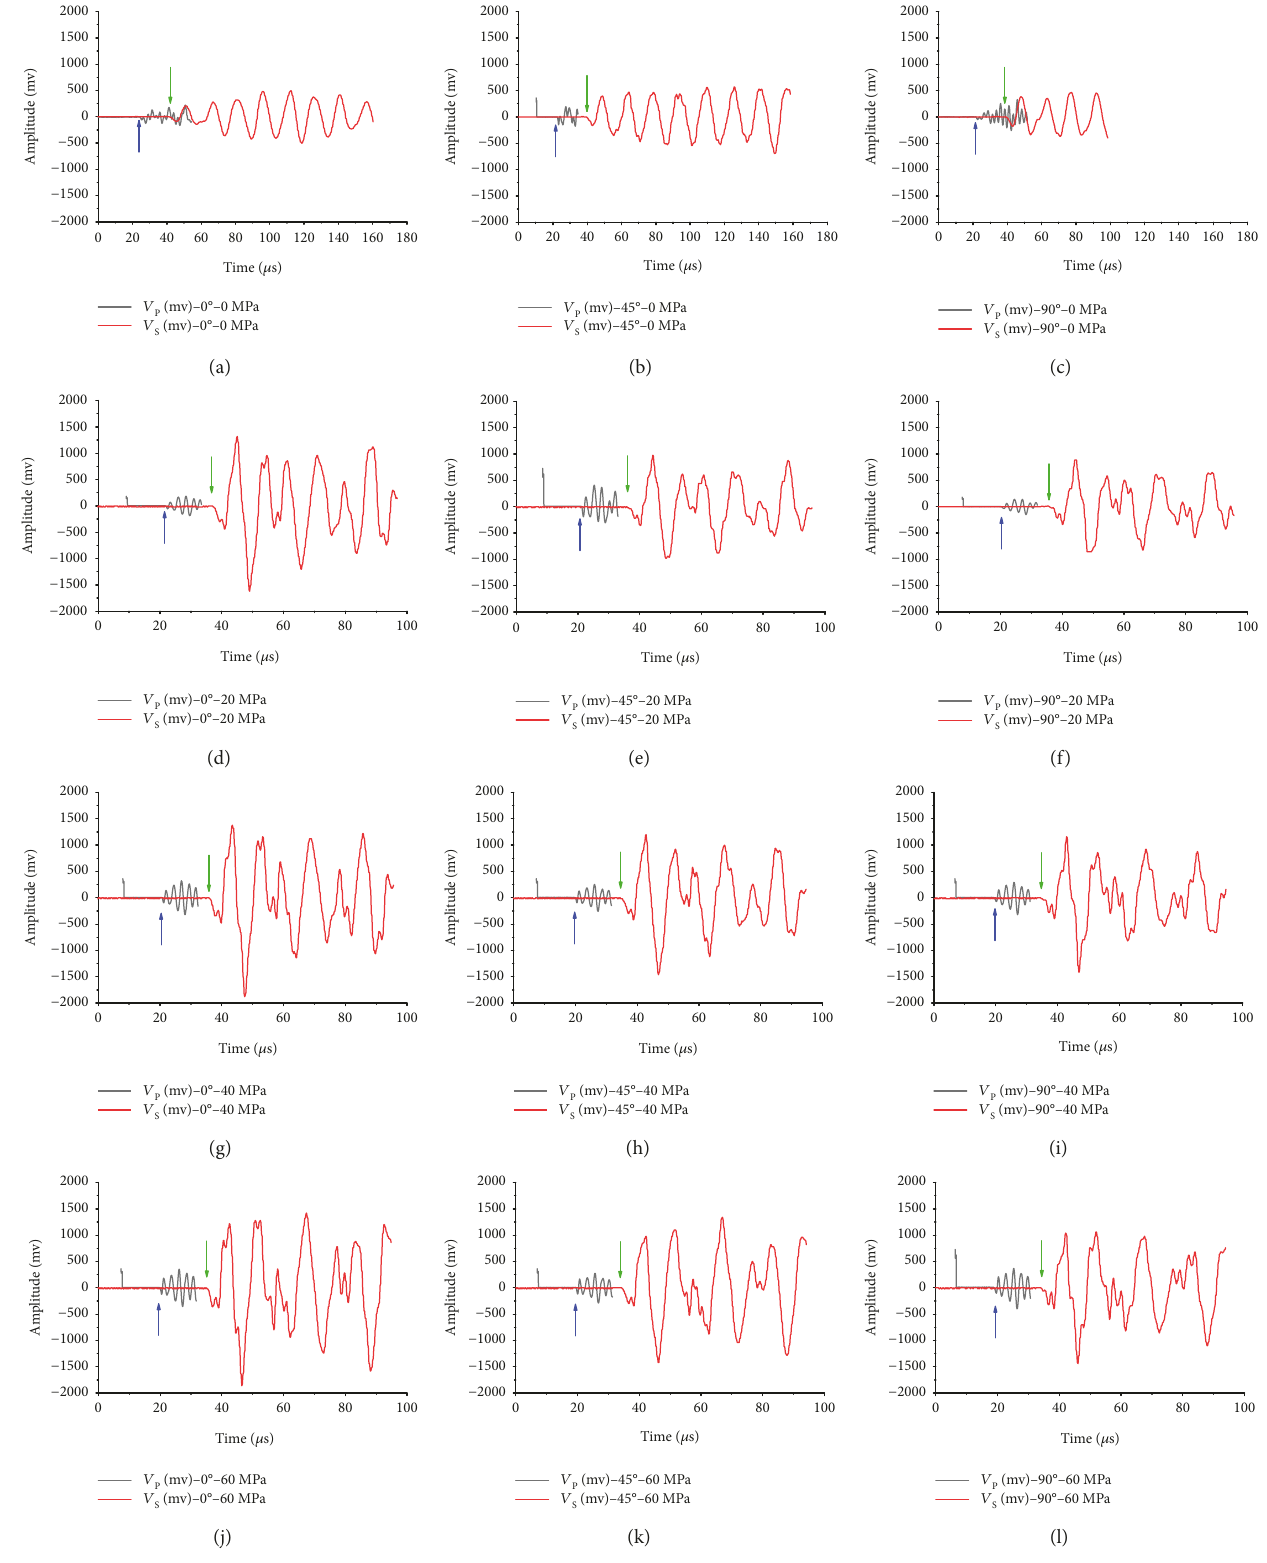
Figure 5: The typical shapes of LMX shale without